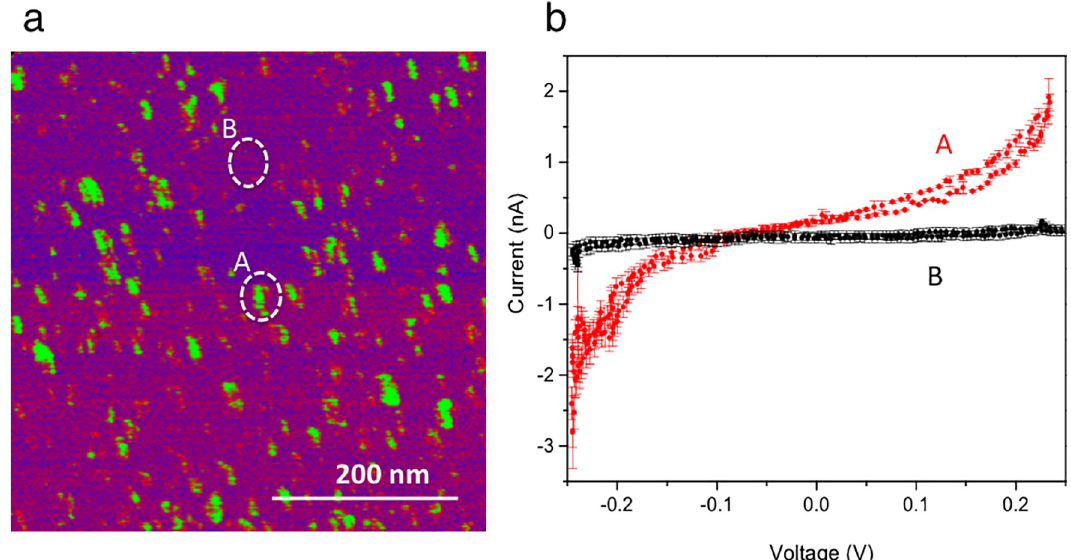
Fig 4. Conductive AFM of SLB with CNTPs channels. (a) The current map for the Pd contact with SLB incorporating CNTPs. The hot spot (green spot) correspond to higher current (red trace) that represent CNT and the background (purple area) correspond to negligible amount of current (black trace) which represent SLB membrane. (b) In the IV curve the red trace collected from the green spot and the back trace collected from the purple area. The green spot has i ~ 1.78 nA ± 0.09 nA and purple area has i ~ 5.86 pA ± 0.98 pA. This current most likely represents the electron conductivity of CNT. (The data are collected from 3 different areas of the AFM image for both green spot and purple area. The error bars are the root mean square of the displacement of the data from the average